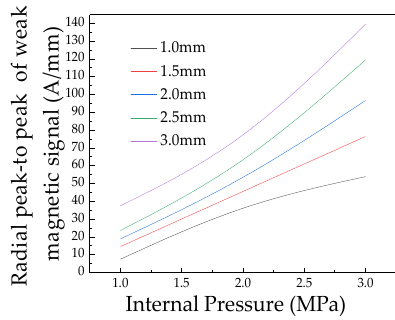
Figure 9. Radial peak-to-peak of weak magnetic signals of different crack depths with internal pressure.